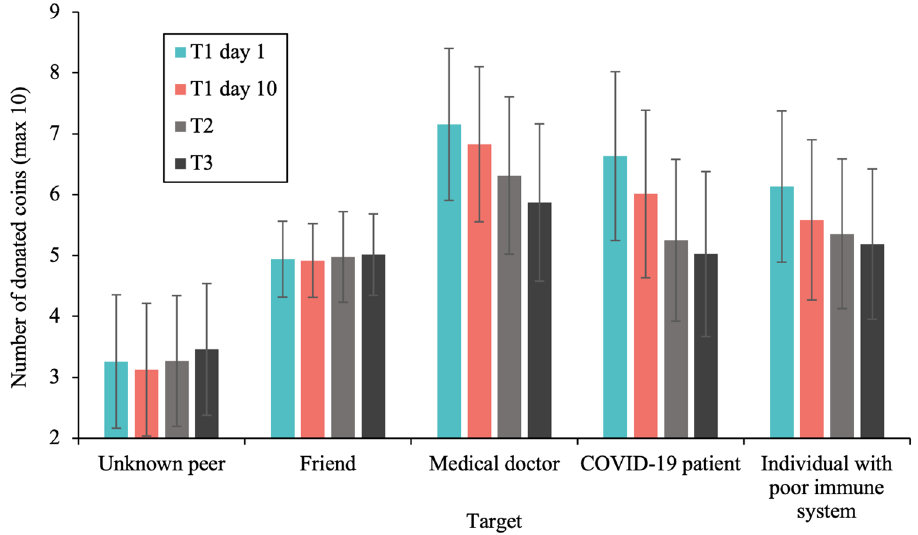
Figure 5. Giving behavior toward all targets in the Dictator Game for all timepoints (T1 day 1, T1 day 10, T2, and T3). Most coins were donated to COVID-19 related targets (i.e., medical doctor, COVID-19 patient, and individual with poor immune system), followed by a friend and an unknown peer. Adolescents showed a decrease in giving behavior to the COVID-19 related targets across time. Error bars denote 95% confidence